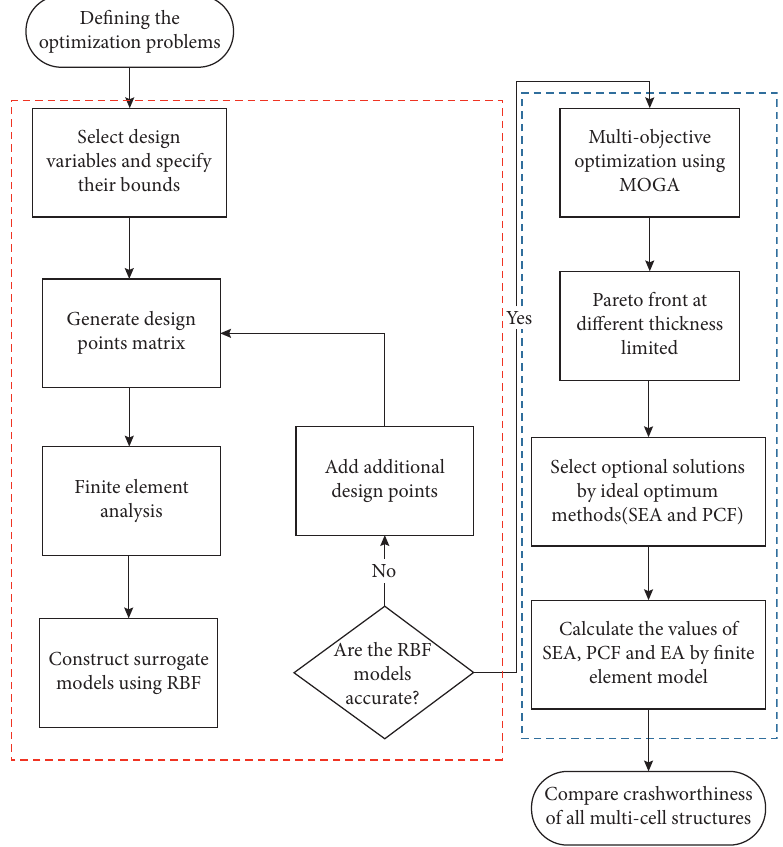
Figure 12: Flow chart of the research